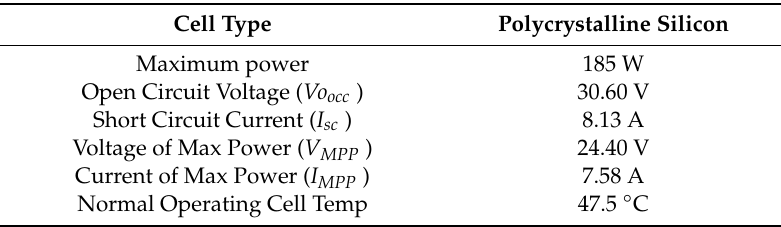
Table 1. Mitsubishi TD185MF5 PV Panel